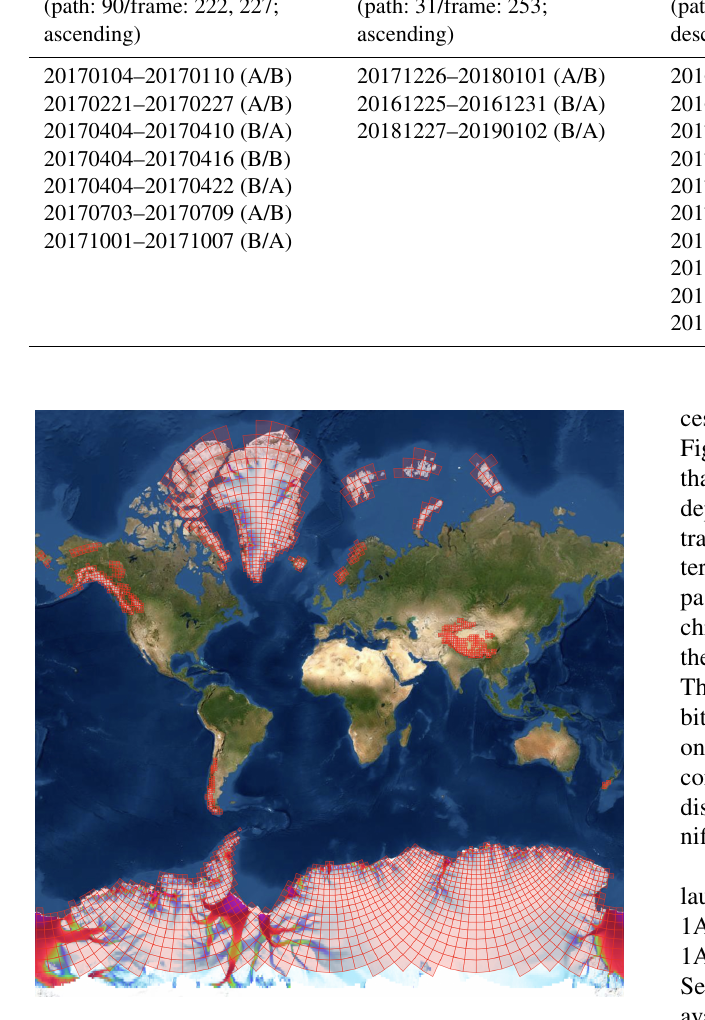
Figure 2. Global view of the spatial coverage of the ITS_LIVE Version 2 dataset (with Sentinel-1 available between 78 ◦ S and 81 ◦ N) which include image-pair products, as well as cloud opti- mized datacubes that contain all ITS_LIVE image-pair products. The ITS_LIVE Version 1.0 Landsat-derived ice velocity mosaic map is overlaid onto the global optical image as a reference ve- locity map, where the red boxes represent the spatial extents of the